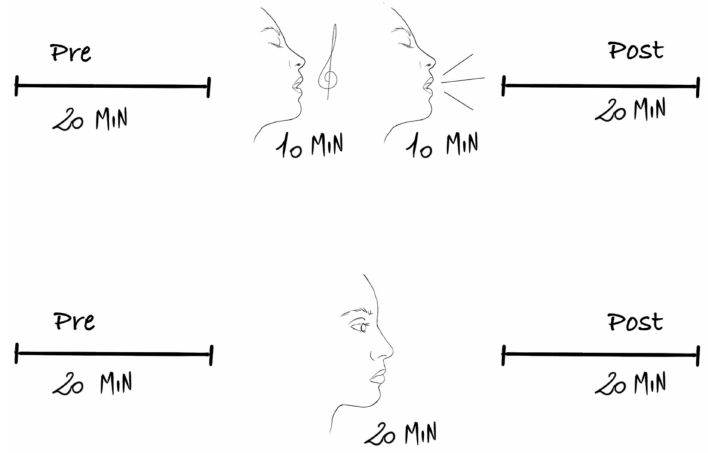
Figure 1. Illustrations of the intervention (top) and the control (bottom) groups. The order of singing and speaking was reversed on the following